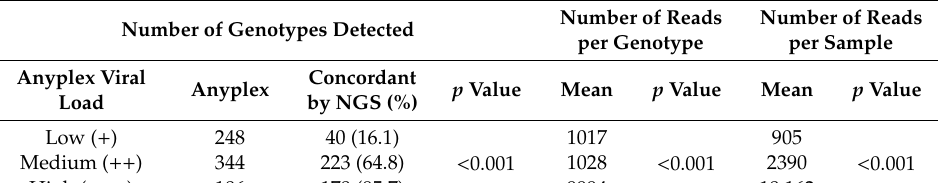
Table 1. Proportion of genotypes detected by next generation sequencing (NGS) stratified by viral load as determined by Anyplex II HPV28.